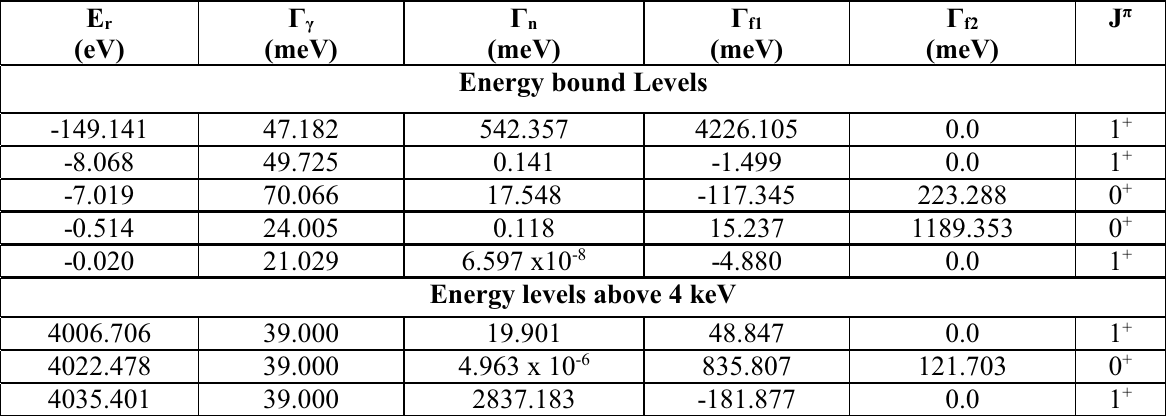
Table I. Resonance energies and parameters of the external